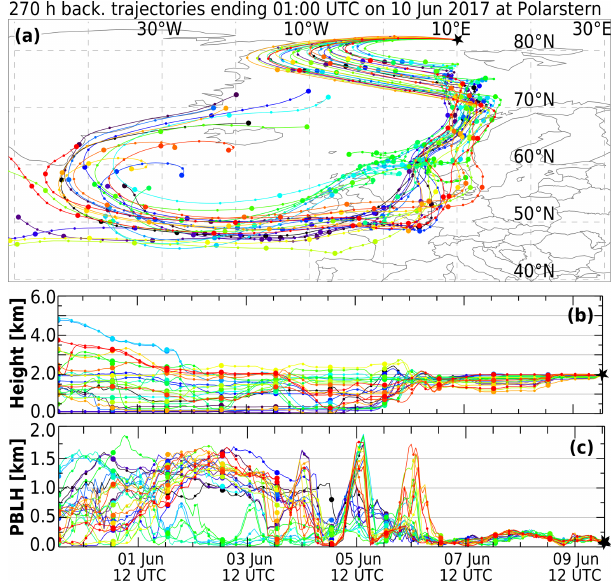
Figure 8. (a) Ensemble of 27 10d backward trajectories arriving at the position of Polarstern at 01:00UTC on 10 June 2017 at 2000m height. Panel (b) shows the height of the trajectory and panel (c) the respective planetary boundary layer height